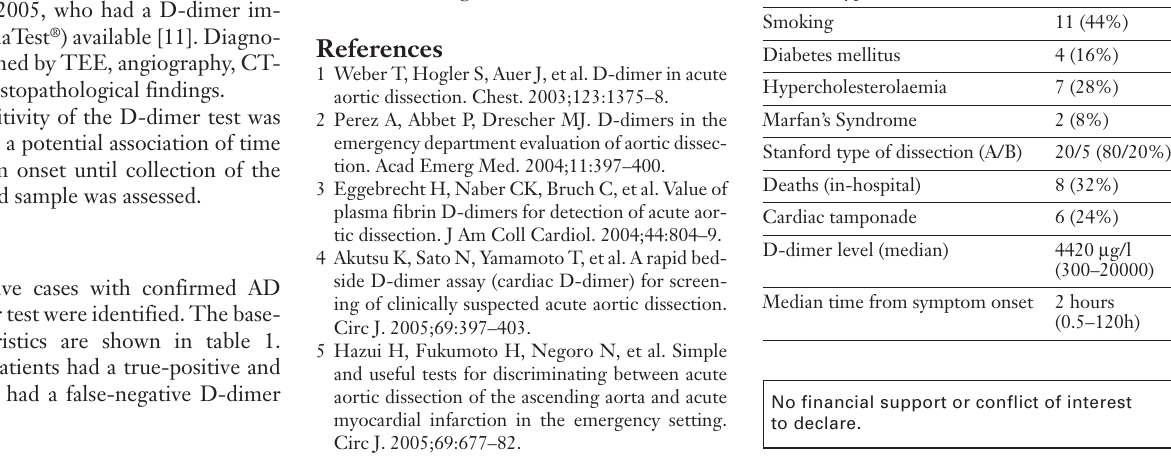
Recent studies evaluating D-dimers in AD.